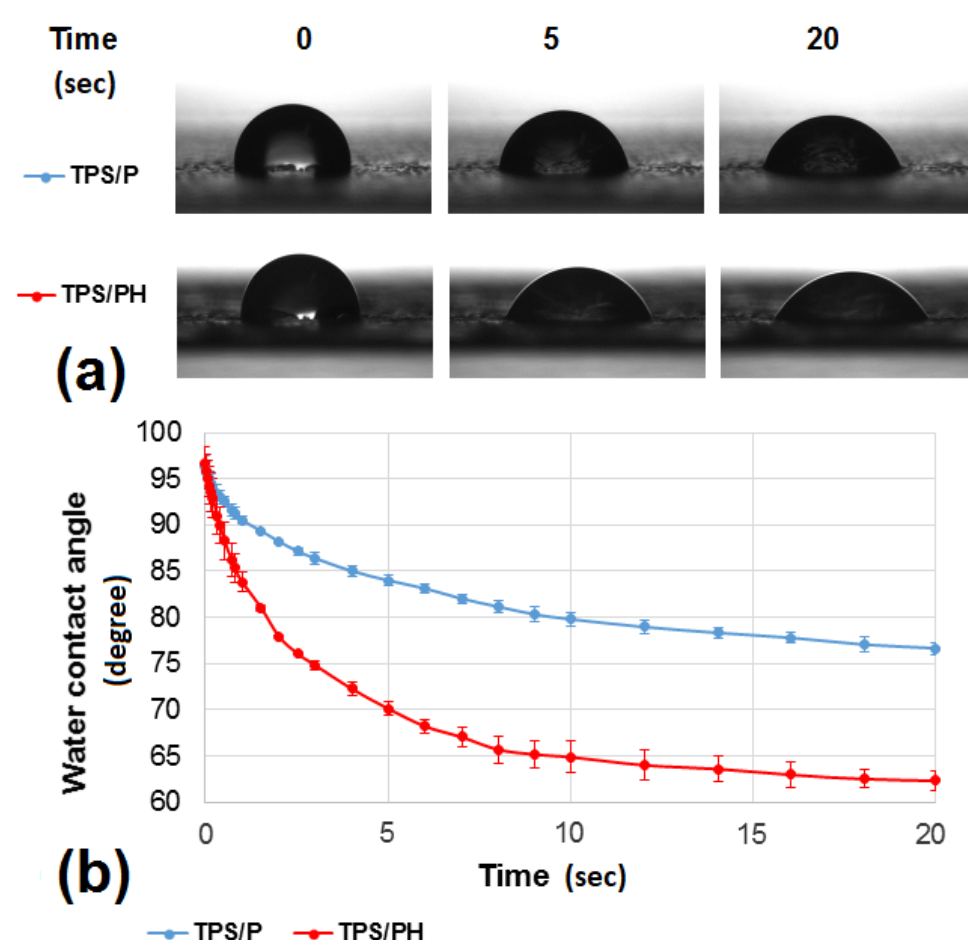
Figure 5. Shape ( a ) and behavior ( b ) of water drops on pure thermoplastic starch film (TPS/P) and thermoplastic starch film with psyllium husk addition (TPS/PH) as a function of time (0–20 s). It is well-known that the water contact angle will decrease with the increasing surface Table 2. Drop volume and surface of contact of the drop with TPS/P and TPS/PH films as a function hydrophilicity, thus being a primary indicator for hydrophobic characterization of polymer of time (0 − 20 s). Values are mean ± SD. materials [51]. The contact angle of biopolymers ranges from 0 ◦ (complete spreading of the liquid onto the solid surface) to 180 ◦ (an unrealistic limit of absolutely no wetting) [52]. A biopolymer can be considered hydrophilic when its contact angle is lower than 90 ◦ , and hydrophobic when the contact angle is higher than 90 ◦